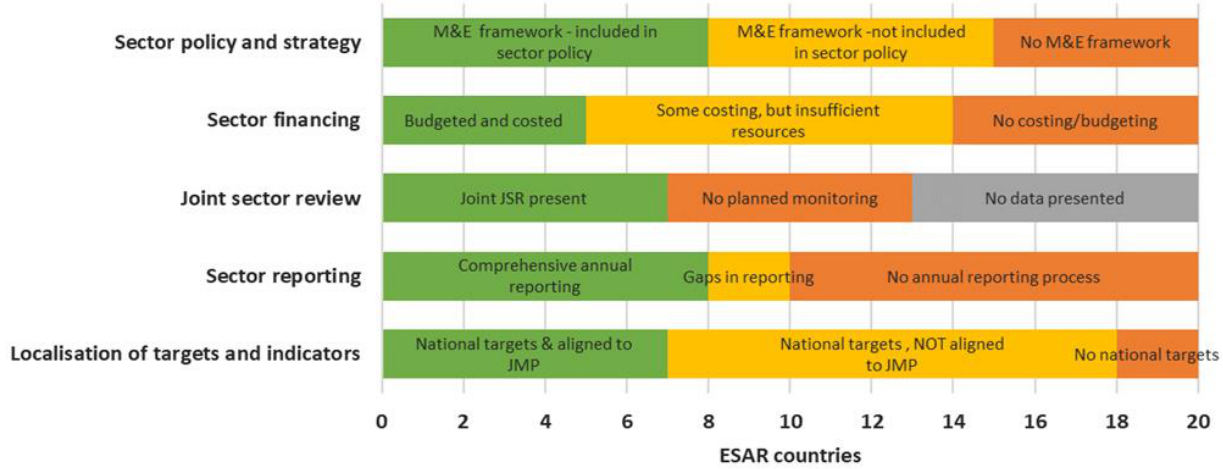
Figure 4. Findings of enabling environment assessment of ESAR countries.